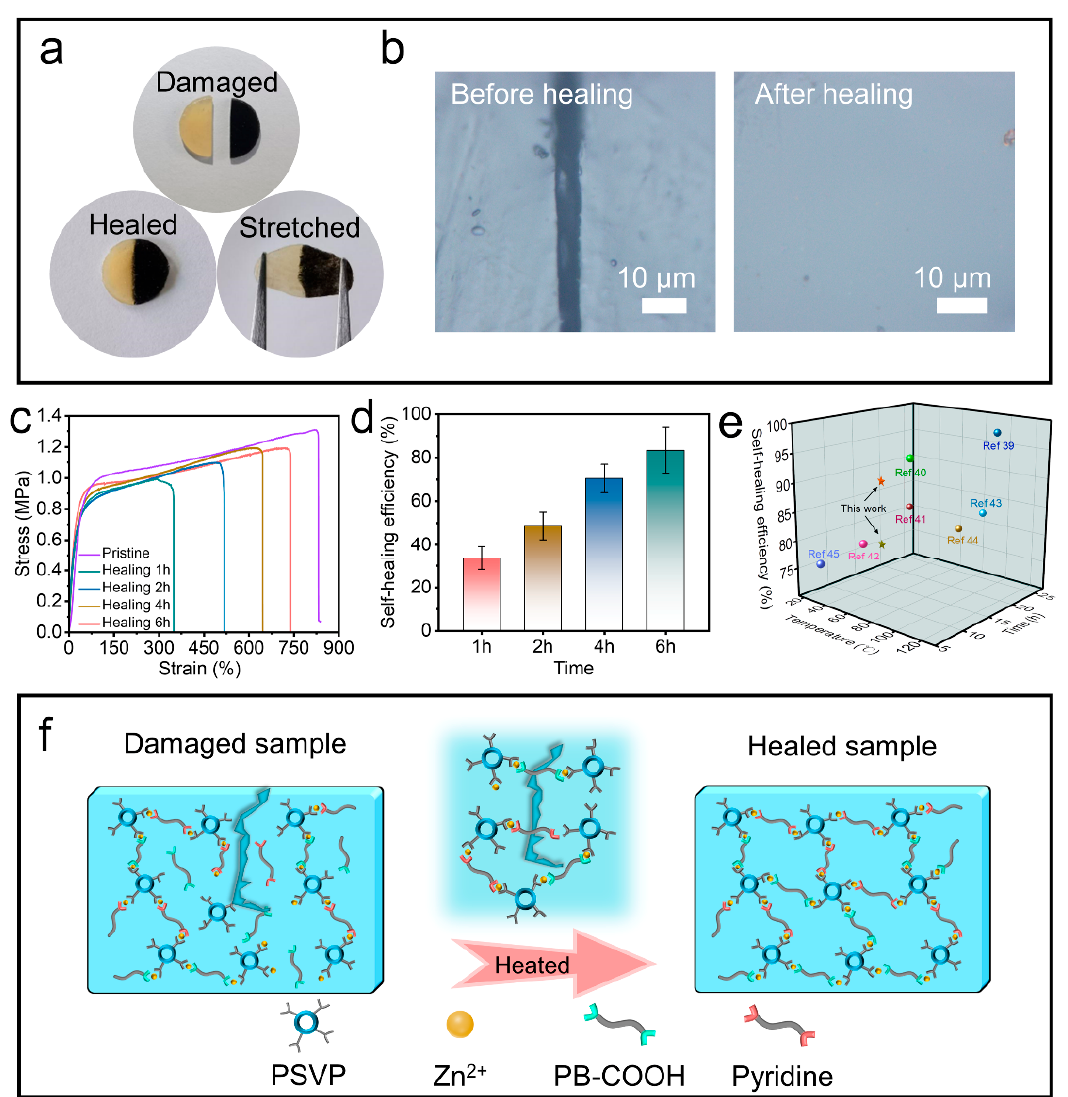
Figure 8. ( a ) Optical images of cut, healed and stretching R2/R2-0.5% specimen. ( b ) Microscope image of the surface of the sample. ( c ) Typical stress–strain curves with different healing times. ( d ) Corresponding healing efficiency of the R2-0.5% at different times. ( e ) Comparison of self-repairing performance using this work with previous reports [39,40,41,42,43,44,45]. ( f ) The proposed self- healing mechanism of R2-0.5%.